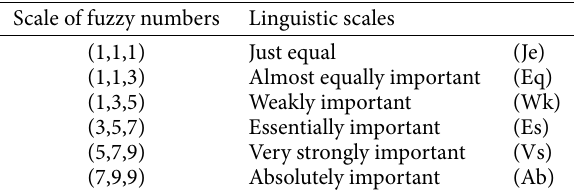
Table 2. Linguistic scale for weight matrix (Hsieh et al. 2004) Scale of fuzzy